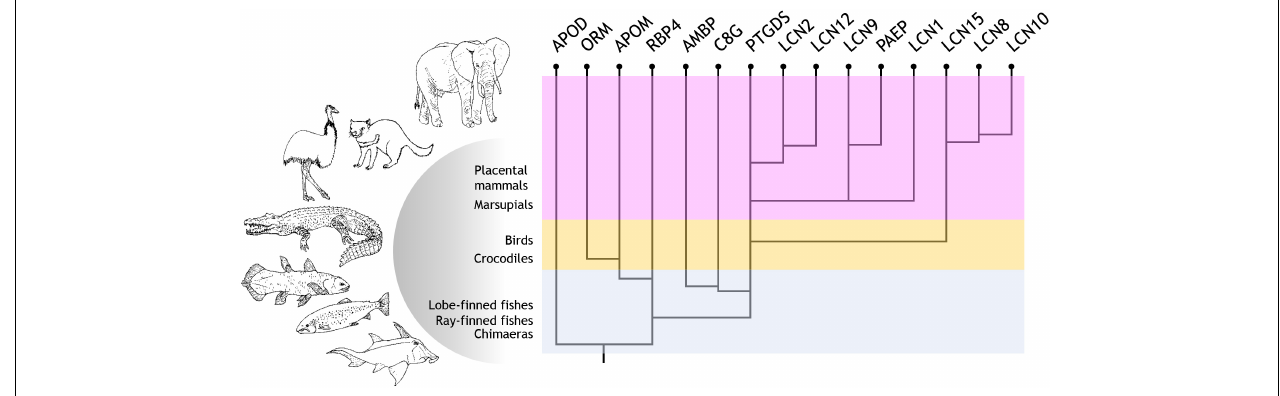
FIGURE 4 | Current proposal for the evolutionary history of Lipocalin in chordates. Evolutionary path suggested for Lipocalin duplication and diversification in chordates. Six Lipocalins evolved during fish evolution, while at least nine novel Lipocalins evolved in terrestrial